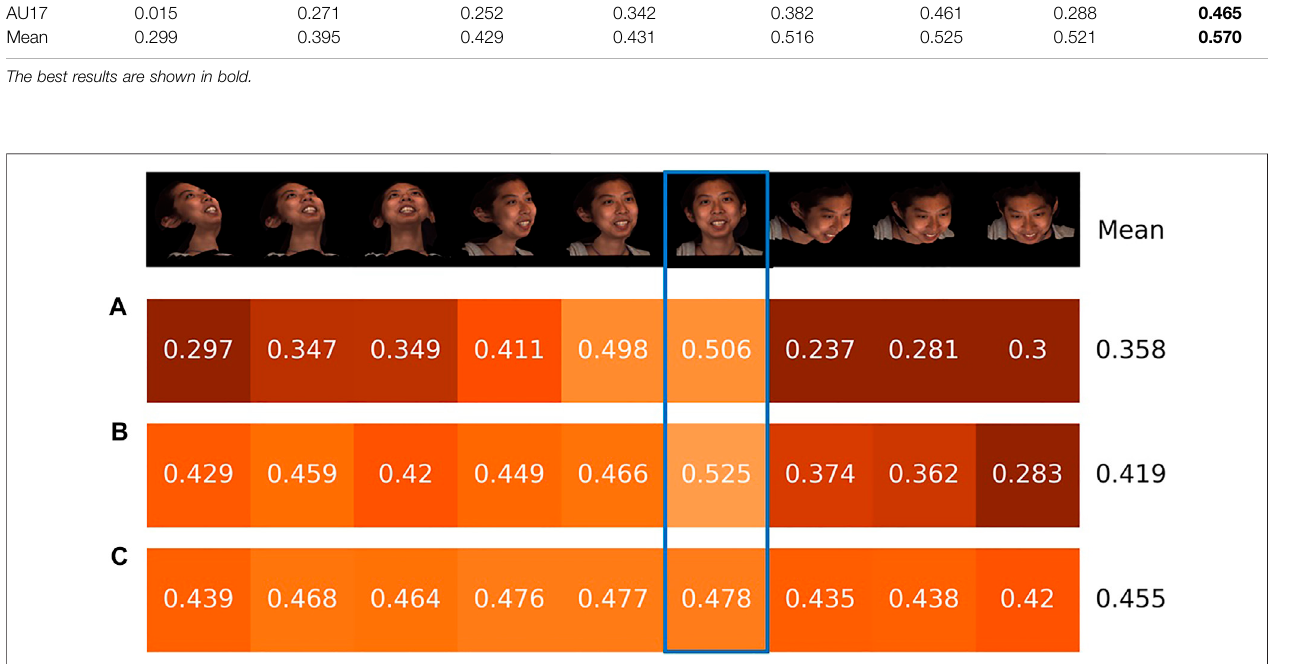
FIGURE5| ICCforFERA2017Testpartitionwithnon-frontalview. (A) real2Dnormalized → real2Dnormalized. (B) synthetic3Dnormalized → real3Dnormalized. (C) 3D augmented synthetic → real 2D normalized. The blue rectangle indicates the performance for frontal view images.